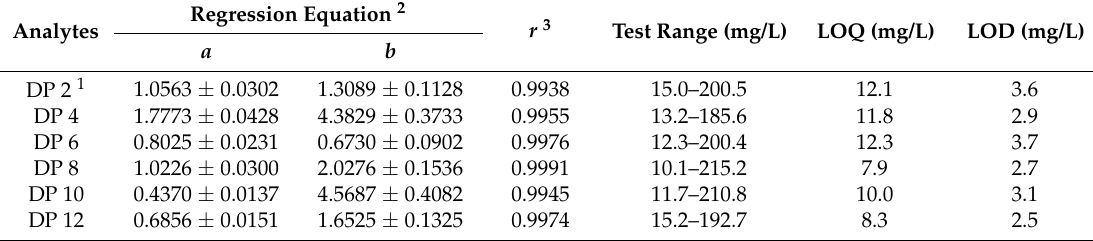
Table 1. Calibration data, limit of quantitation (LOQ), and limit of detection (LOD) of the neoagaro- oligosaccharides.